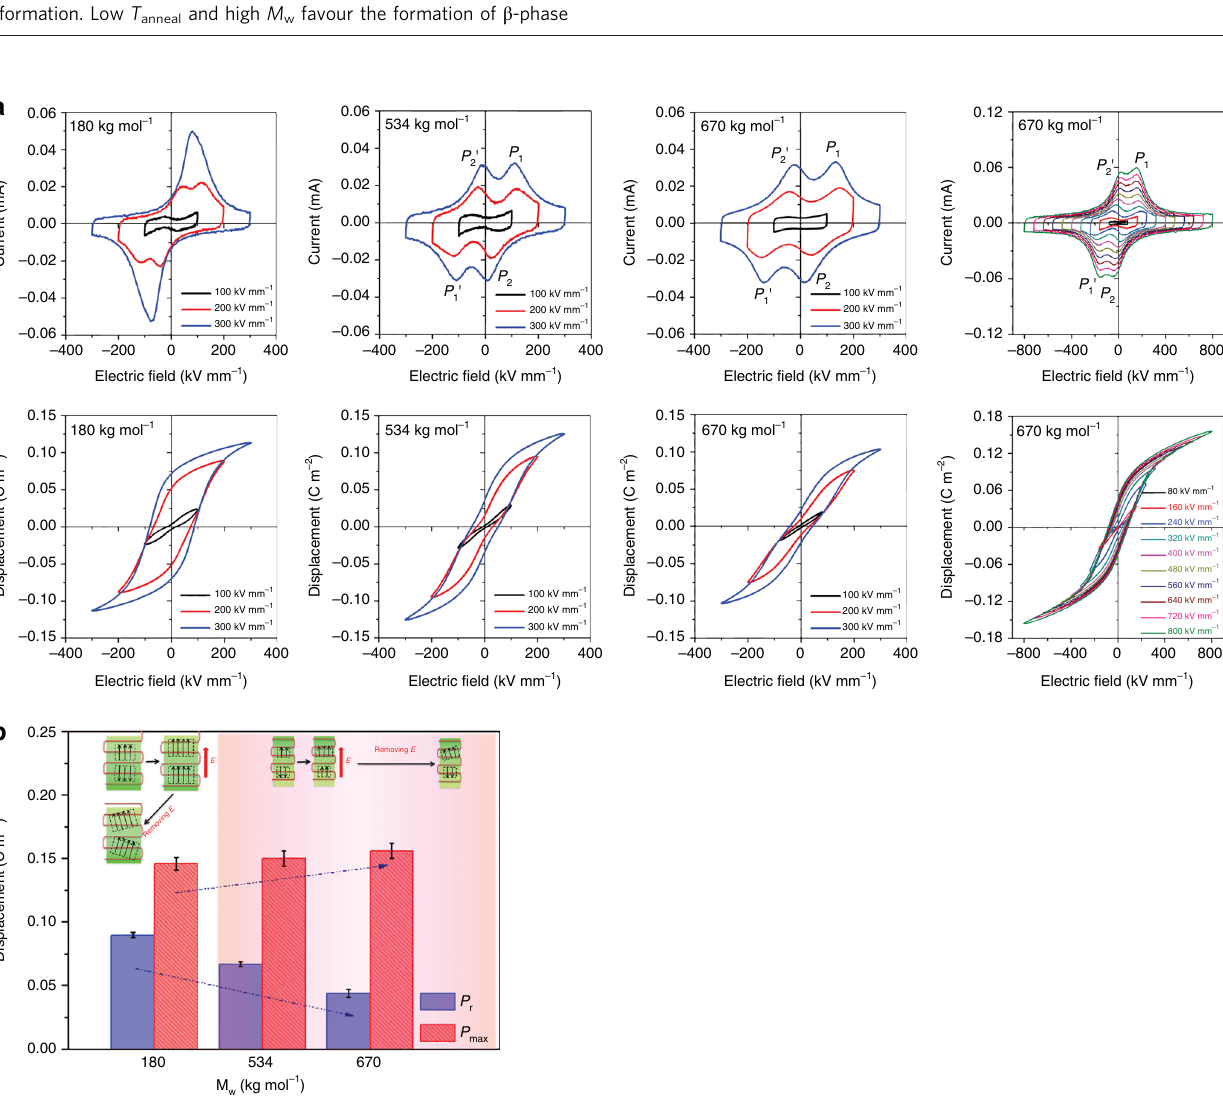
Fig. 4 Ferroelectric properties of pressed and folded poly(vinylidene fl uoride) samples. a Bipolar current – electric fi eld ( I – E ) and displacement – electric fi eld ( P – E ) loops of P&F PVDF after seven cycles with different M w of 180, 534 and 670 kg mol − 1 . P 1 and P 1 ′ denote the peaks appeared during the application of electric fi eld. P 2 and P 2 ′ denote the peaks appeared during the reversal of electric fi eld. b A comparison of bipolar remnant polarization P r and maximum polarization P max of P&F fi lms with different M w , and schematic diagram of polar structure change during charging and discharging processes, where the green blocks represent the crystallites, red lines represent the polymer chains with arrows denoting the dipole moment and the dashed lines highlight the polar structure, which was enhanced and grew larger under electric fi piezoelectric resonance peak could be detected in the frequency P&F samples with high M w (670 – 700 kg mol − 1 ) exhibited lower dependence of the dielectric spectra of the poled 670 – 700 kg mol − 1 piezoelectric d 33 coef fi cients ( − 3.0/ + 4.2 compared to − 10.8/ + 12.0 P&F fi lms, while a small but clear peak (thickness extension mode) of P&F samples with low M w of 180 kg mol − 1 ) after the ferroelectric measurement up to 300 kV mm − 1 . No obvious can be seen for the poled 180 kg mol − 1 P&F fi lms (Supplementary